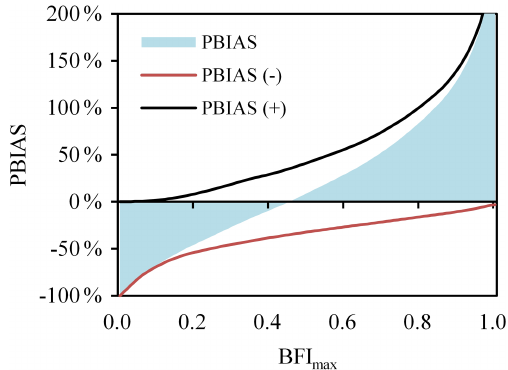
Figure 2. The biases between daily baseflow series calculated by the Eckhardt and CMB methods for the United States Geological Survey (USGS) station 02297100 varied with BFI max . PBIAS is total relative bias, PBIAS(–) is the total negative relative bias, and PBIAS( + ) is the total positive relative